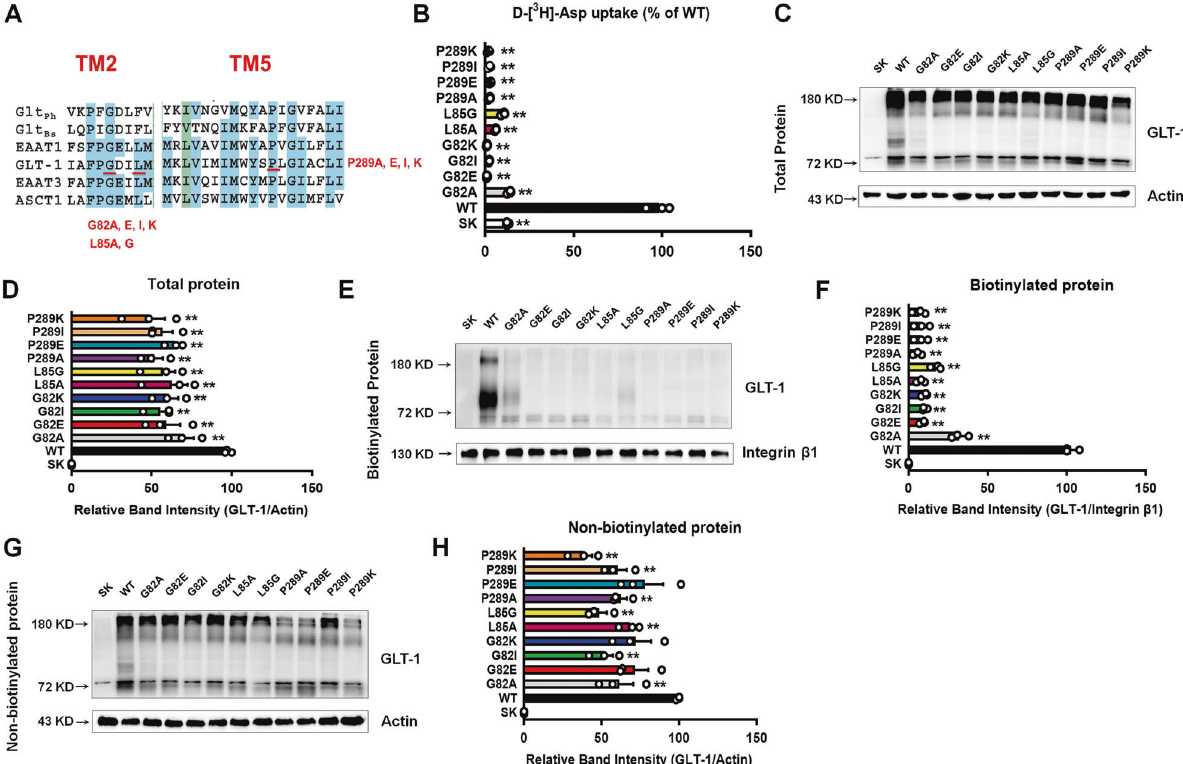
Fig. 3 Epileptic variants did not affect the side-chain structure of GLT-1. A The three epileptic variants were mutated with amino acids with similar properties as the original amino acids (G82A, G82E, G82I, G82K; L85A, L85G; P289A, P289E, P289I, P289K). B After transfection with different plasmids, D-[ 3 H]-Asp uptake activity was determined. n = 3 per group. The representative blots and quanti fi cation of total proteins ( C , D ), biotinylated membrane proteins ( E , F ), and non-biotinylated proteins ( G , H ) of GLT-1 were measured by Western blot. n = 3 per group. Results are expressed as mean ± SD. ** P < 0.01 vs. WT. Statistical signi fi cance was determined using one-way ANOVA and Tukey ’ s tests for post hoc